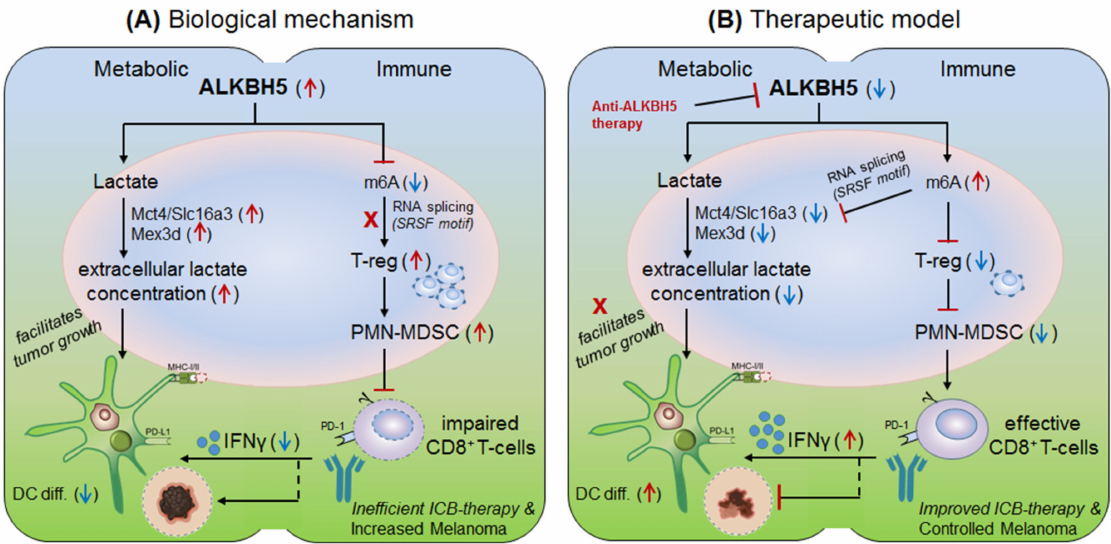
Figure 6. Therapeutic model targeting intracellular checkpoint ‘ALKBH5’ in melanoma. ( A ) Biological mechanism: The ALKBH5 abnormally expressed in melanoma and colorectal cell carcinomas, and impairs the efficacy of anti-PD-1 therapy by (i) recruiting immunosuppressive; regulatory T-cell (T-reg) and polymorphonuclear myeloid derived suppressor cells (PMN-MDSC) abundances in the TME. (ii) by impairing DC-differentiation resulting in decreased CD8 + T-cell effector functions. (iii) by increasing extracellular lactate availability to the tumors by up-regulating the expression of Mct4/Slc16a3 genes due to decreased m6A-methylation mark associated mechanism. ( B ) Therapeutic model: (i) Anti-ALKBH5 therapy: selective inhibition of ALKBH5 [168] by increasing m6A methylation-mediated inhibition of crucial genes essential to increase the efficacy of CD8 + T-effector cells. (ii) T-reg/PMN-MDSCs depletion therapy: could also show the therapeutic propensity by rescuing the immunosuppressive environment. (iii) Increasing DC-differentiation: could be also a promising approach to enhance DC-mediated CD8 + T-cell effector function. (iv) Targeting metabolic genes: could be an alternative approach to control melanoma tumorigenesis by limiting extracellular lactate accumulation in the TME. Collectively, all these approach seems promising in overcoming the issues associated with ICB